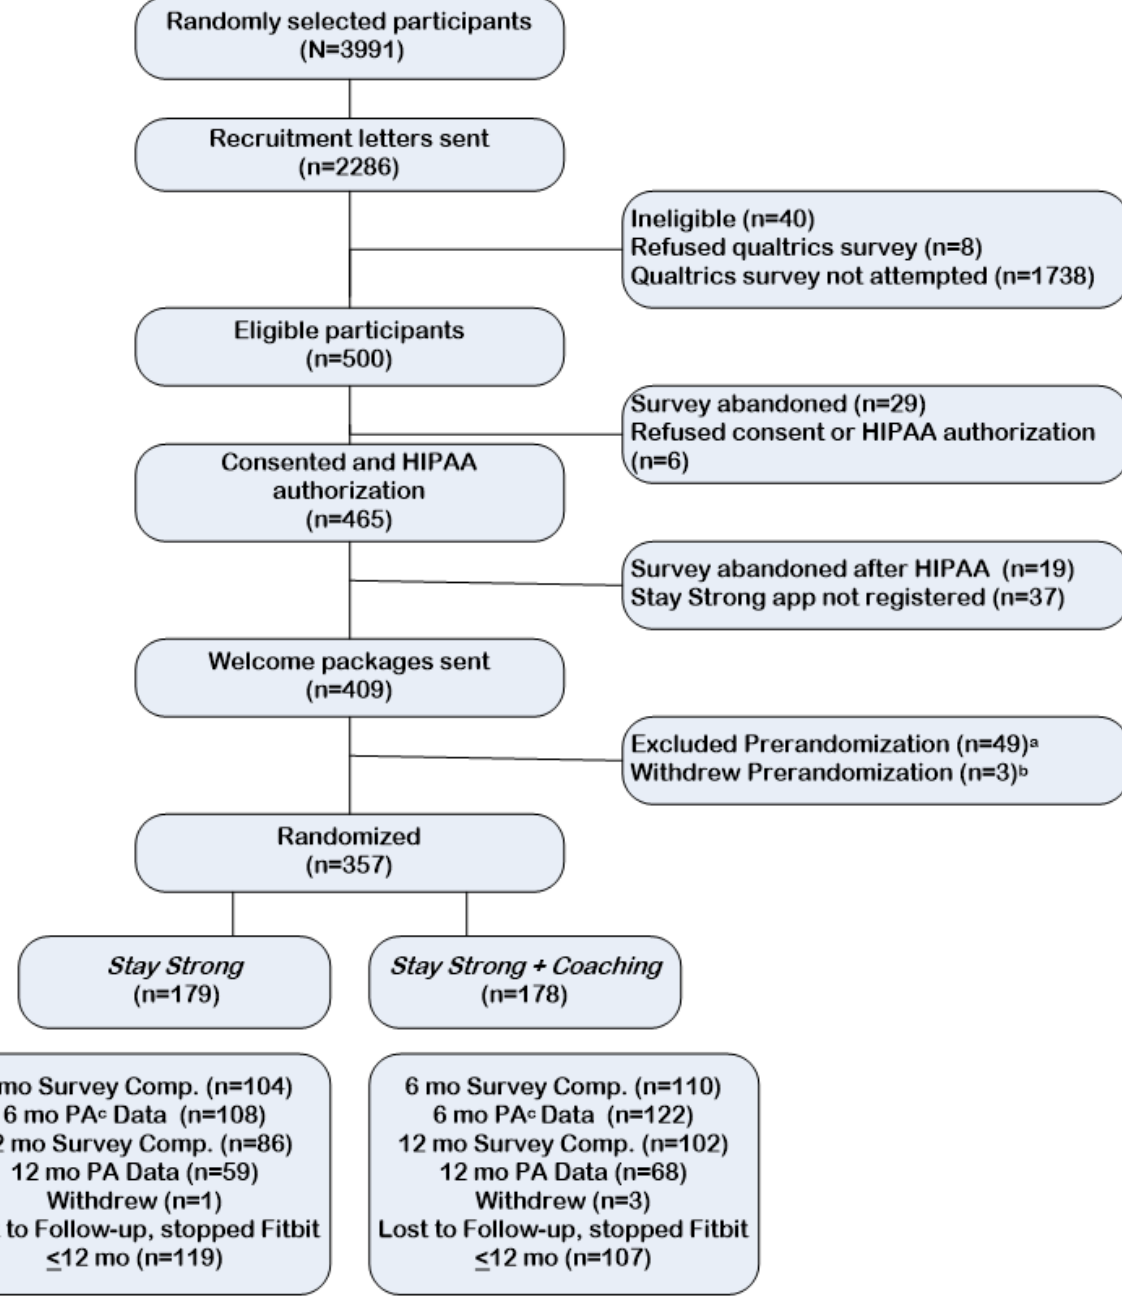
Figure 1. CONSORT flow of recruitment through